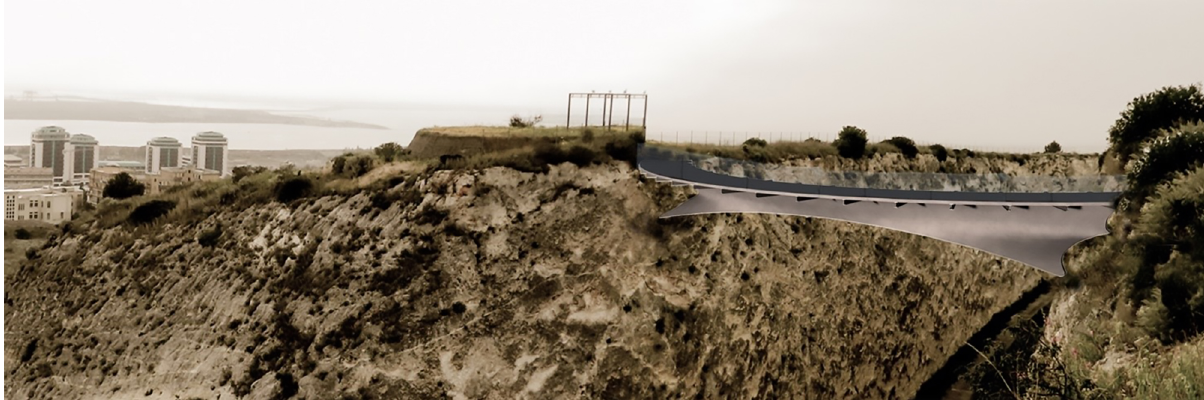
Figure 15: Photomontage of the curved shell-supported footbridge over Tuvixeddu canyon in Cagliari, Italy